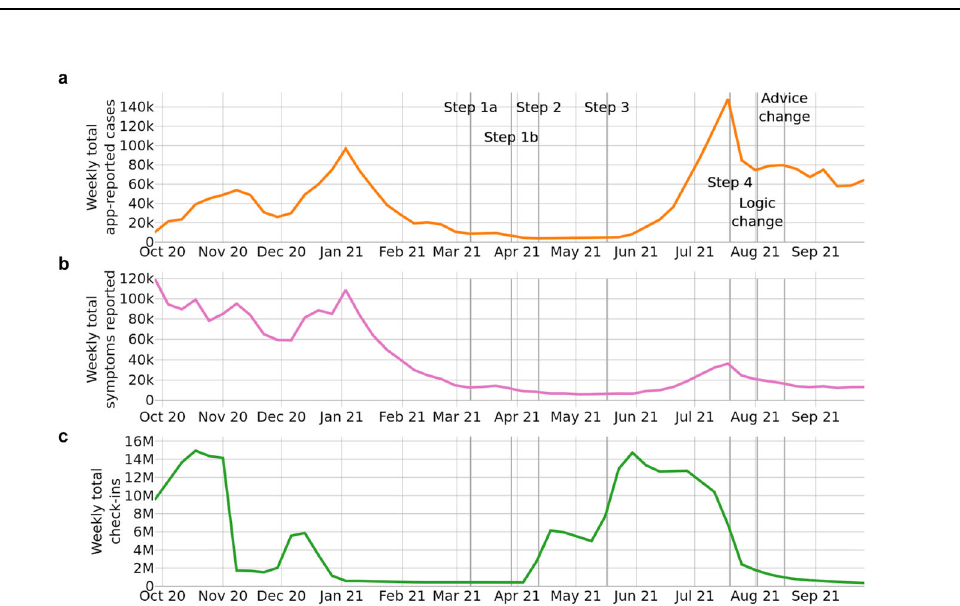
Fig. 2 | App engagement. Weekly numbers of a app-reported cases, b individuals reporting symptoms through the app, and c check-ins via the app ’ s QR code functionality. Annotations refer to: the steps of a ‘ roadmap out of lockdown ’ 16 ; a change to the contact tracing logic of the app for the contacts of asymptomatic